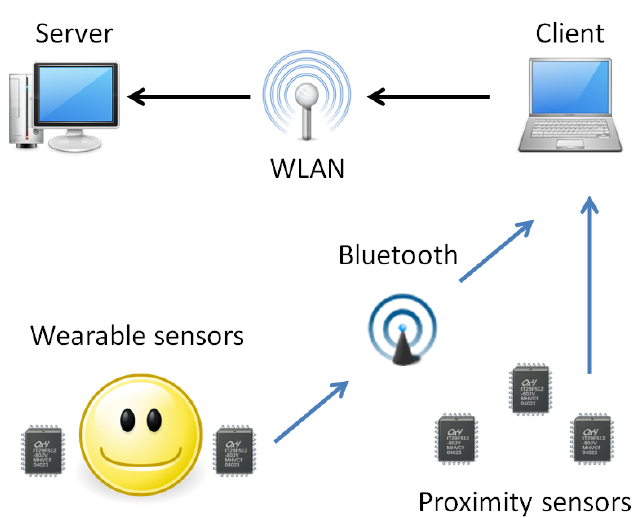
Figure 1. Overview of the sensor